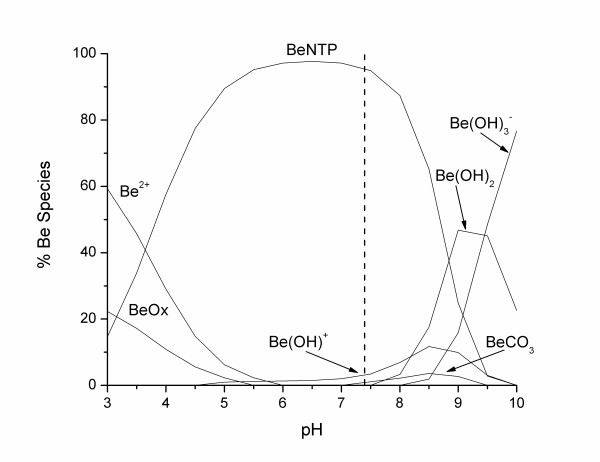
Influence of NTP on the speciation of Be in the LMW of serum fluid ([Be] 5.8*10-5 mM; [NTP] 10-4 mM; [Ca] 1.3 mM; [Cl] 108 mM; [CO3] 24 mM; [K] 4.2 mM; [Mg] 0.8 mM; [Na] 142 mM; [PO4] 2 mM; [SO4] 0.5 mM; [Cit] 0.1 mM; [Ox] 0.01 mM).